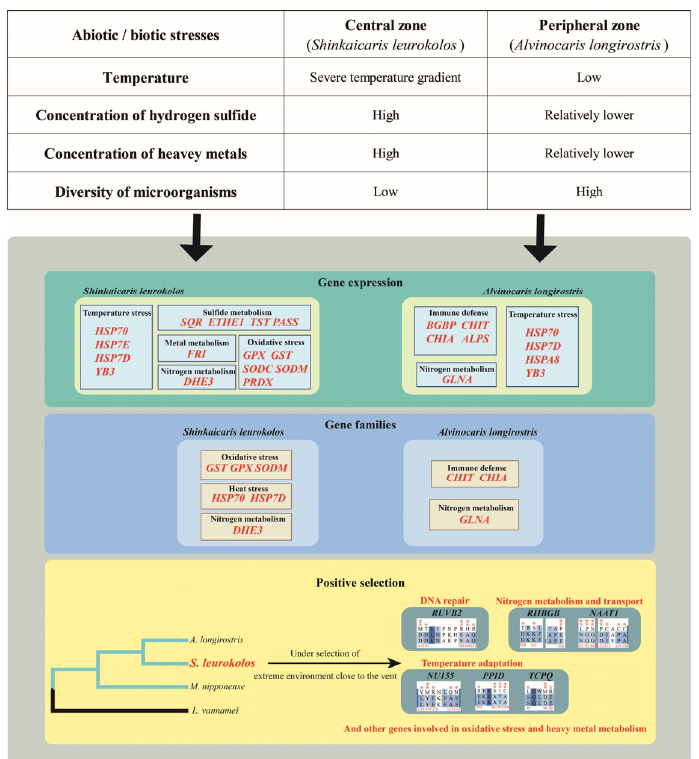
Figure 3. The outline of the molecular basis of adaptation to different ecological niches of a hydrothermal vent ecosystem in Shinkaicaris leurokolos and Alvinocaris longirostri s. It depicts the main abiotic/biotic external stresses to the shrimps, and key gene sets that may play relatively important roles in the adaptation of the two shrimps to their microenvironments. Contributions of key highly expressed genes to the adaptability are described in a green square. Contributions of key significantly expanded gene families to the adaptability are described in a blue square. Finally, contributions of key positively selected genes of S. leurokolos to its adaptive evolution are described in a yellow square. The positive selection analysis is performed based on the phylogenetic tree of the four decapods and the orthologues of the three shrimps (branches in blue). Double asterisks stand for the amino acids in S. leurokolos with a BEB posterior probability that is higher than 99%, and one asterisk stands for the sites with a posterior probability larger than 95% but lower than 99%. HSP70 , heat shock cognate 70 kDa protein ; HSP7E , heat shock 70 kDa protein cognate 5 ; HSP7D , heat shock 70 kDa protein cognate 4 ; YB3 , cold shock Y-box protein ; PAPSS , 3’-phosphoadenosine 5’-phosphosulfate synthase ; FRI , ferritin ; DHE3 , glutamate dehydrogenase , mitochondrial ; GPX , glutathione peroxidase ; GST , glutathione S - transferase ; SODC , copper/zinc superoxide dismutase ; SODM , cytosolic manganese superoxide dismutase ; PRDX , peroxiredoxin ; BGBP , beta - 1 , 3 - glucan - binding protein ; CHIT , endochitinase ; CHIA , acidic mammalian chitinase ; ALPS , anti - lipopolysaccharide factor ; HSPA8 , heat shock cognate 71 kDa protein ; RUVB2 , RuvB - like 2 ; RHBGB , ammonium transporter Rh type B - B ; NAAT1 , sodium - dependent nutrient amino acid transporter 1 ; NU155 , nuclear pore complex protein Nup155 ; PPID , peptidyl-prolyl cis - trans isomerase D ; TCPQ, T - complex protein 1 subunit theta